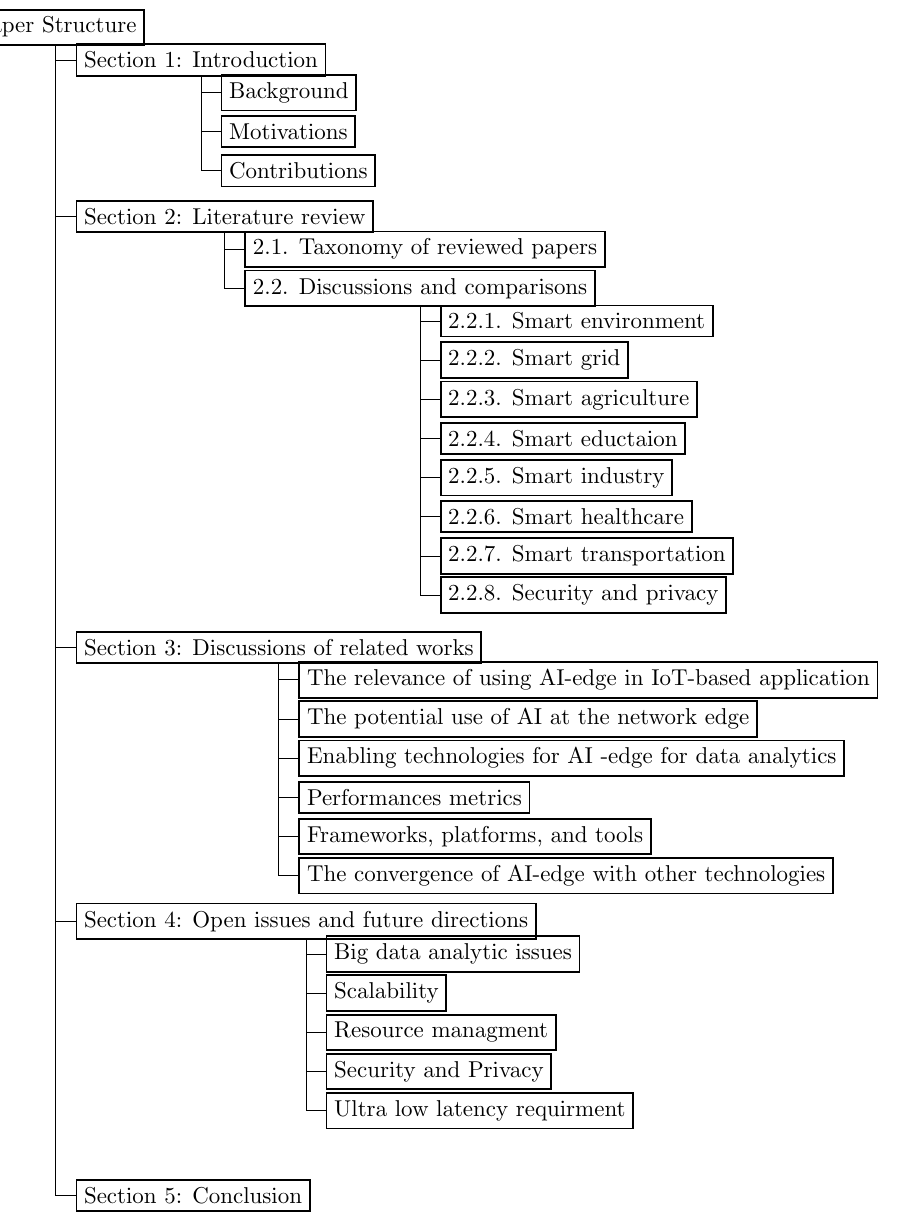
Figure 1. A schematic overview of the paper organization